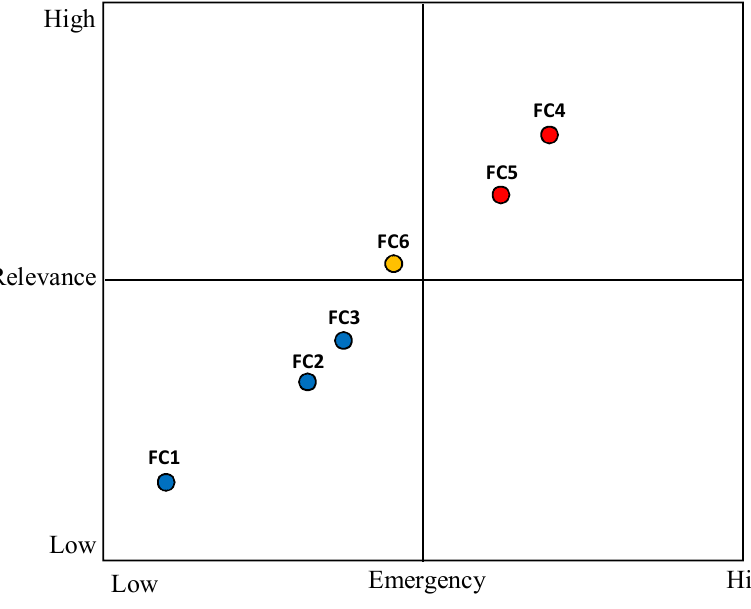
Fig.1. IT portfolio on the relevance–emergency matrix in